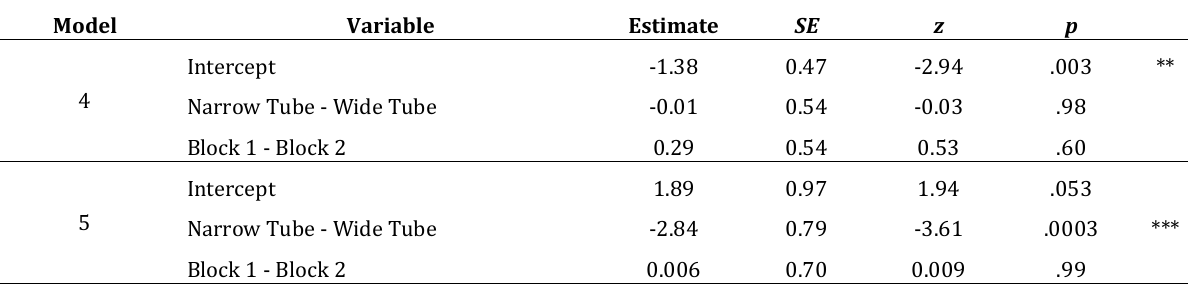
Results from GLM (Model 4) and GLMM (Model 5) Examining Data of Experiment 2 Model Variable Estimate SE